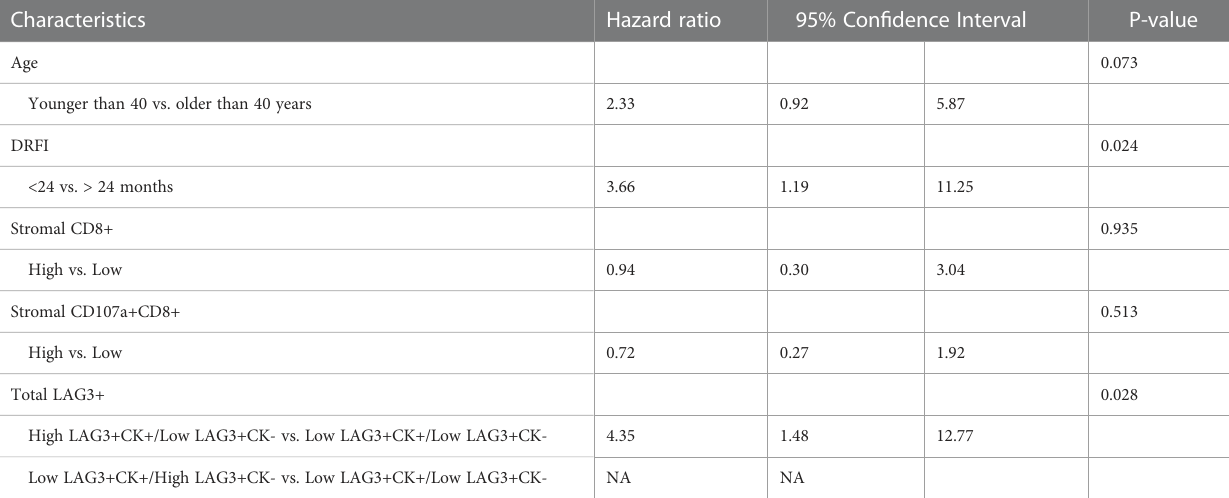
TABLE 2 Multivariate analysis of clinico-pathological factors for ICI-PFS (n=37).